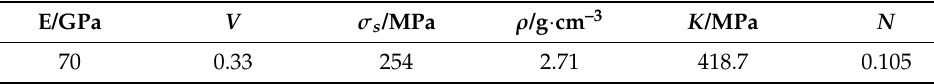
Figure 1. Stress–strain curve of 6082 aluminum alloy. Table 1. Mechanical properties of aluminum alloy 6082-T6.